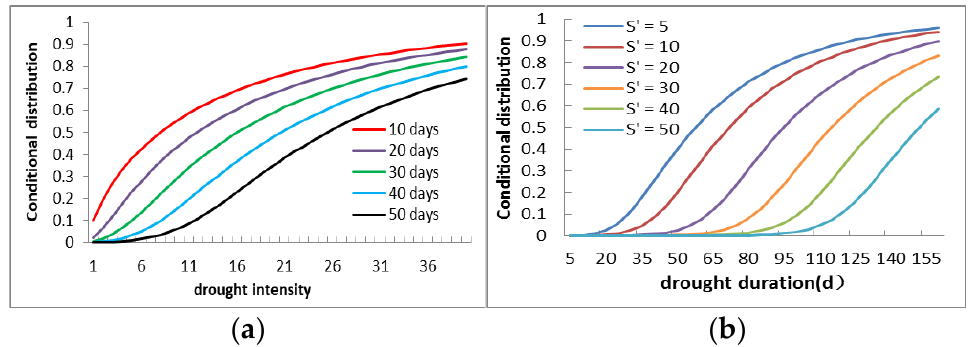
Figure 6. Conditional distribution of drought intensity when the drought duration exceeded d′ ( a ) and the conditional distribution of drought duration when the drought intensity exceeded s′ ( b ) at the Fuxin station.